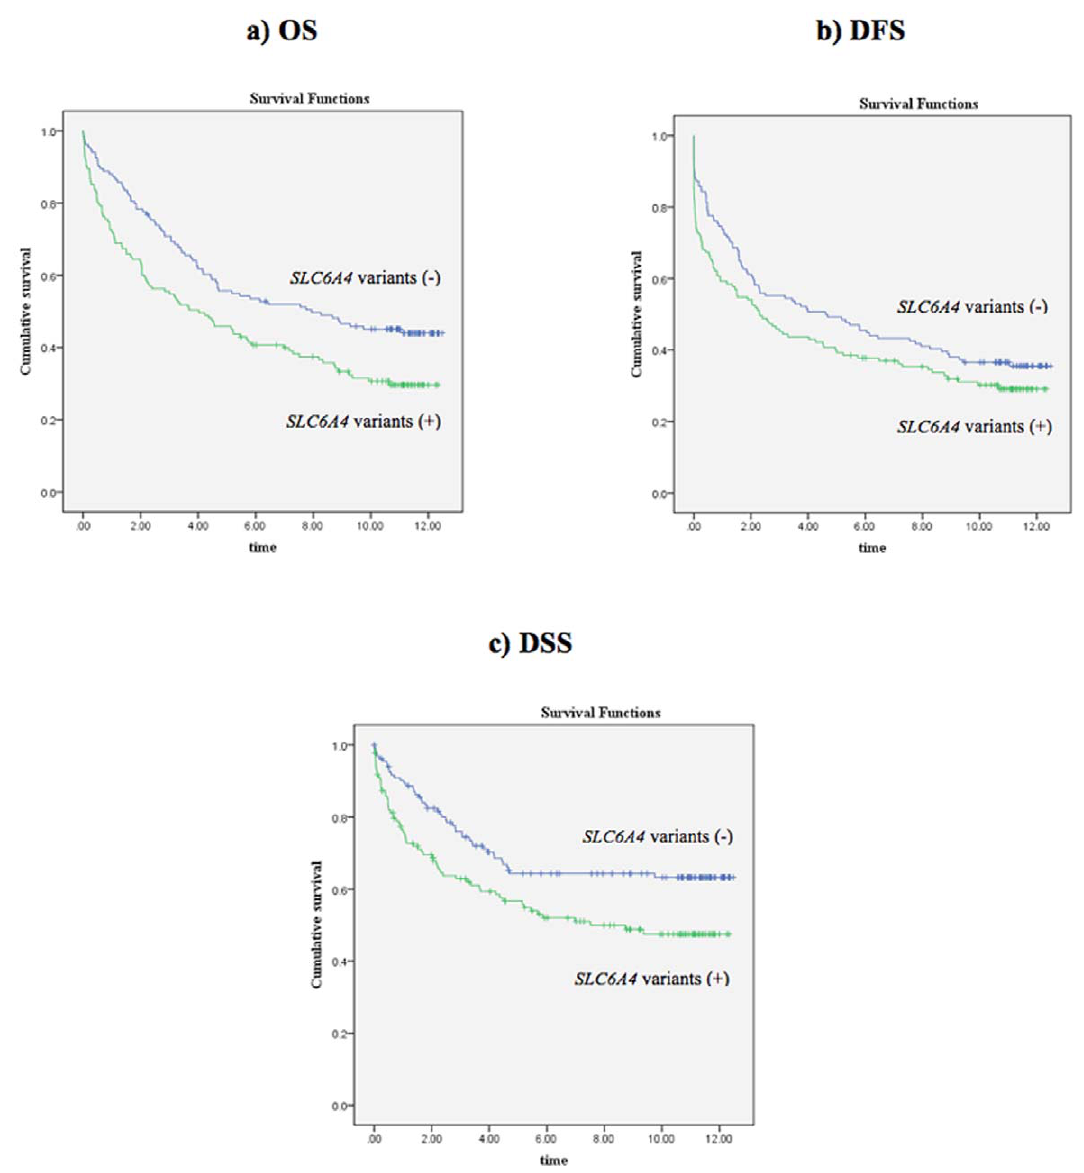
Figure 2. Kaplan-Meier survival curves for the combined genotypes of three SLC6A4 polymorphisms. a) OS (p=0.005, log-rank test), b) DFS (p=0.104, log-rank test), and c) DSS (p=0.008, log-rank test). Time is shown in years.